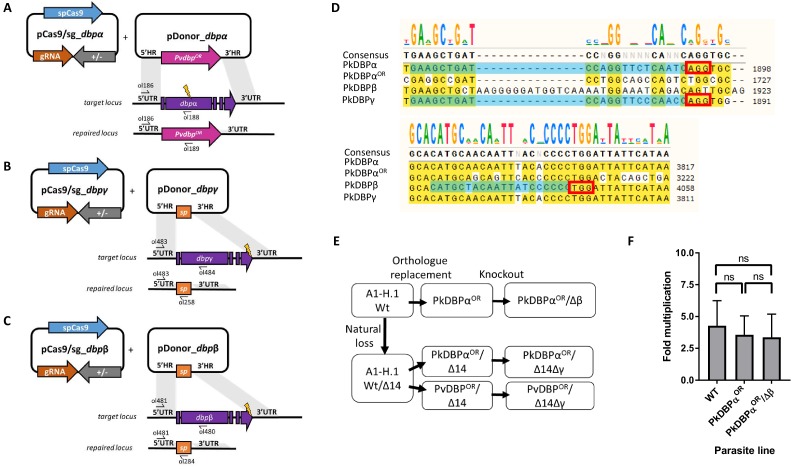
Transgenic P. knowlesi DBP orthologue replacement, knockout design and genotypic analysis.(A) Schematic of CRISPR-Cas9 strategy. Integration of the PvDBP into the target PkDBPα locus via homologous recombination. Arrows indicating oligo positions for diagnostic PCRs. (B) Schematic showing deletion of the target PkDBPγ locus and replacement with a spacer sequence. (C) Schematic showing deletion of the target PkDBPβ locus and replacement with a spacer sequence. All primer sequences are shown in Figure 5—source data 2. (D) Nucleotide sequence alignment of PkDBPα, PkDBPαOR, PkDBPβ and PkDBPγ guide sequences. The chosen guide sequences for transfections are highlighted in blue. PAM sites are highlighted in a red square. (E) Flow chart indicating generated transgenic DBP parasite lines. Wild type parasites that naturally lost 44 kb at one end of chromosome 14 (WTΔ14) were first edited by orthologous replacement of PkDBPα with the recodonised gene (PkDBPαOR) or P. vivax DBP (PvDBPOR) and clonal lines established by limiting dilution cloning. Both clonal parasite lines were edited by knockout of PkDBPγ (PkDBPαOR/Δ14Δγ and PvDBPOR/Δ14Δγ), which were cloned before use in invasion assays and assays of GIA. WT parasites without loss of 44 kb at the end of chromosome 14 were edited by knockout of PkDBPβ (PkDBPαOR/Δβ) (F) Bar chart showing mean fold replication of parasites lines in a FACS-based invasion assays over one growth cycle (24 hr). Assays were carried out in three biological independent experiments in human blood. Error bars denote ±1 SD. Data points represent the mean single cycle growth rate. Replication rates of the parasites lines were compared by using unpaired one-way ANOVA with Tukey’s multiple comparisons test of means. There are no significant differences in fold multiplication rates ns: p>0.05 (Figure 4—figure supplement 1—source data 1).10.7554/eLife.45829.015Figure 4—figure supplement 1—source data 1.Source data for graphs.